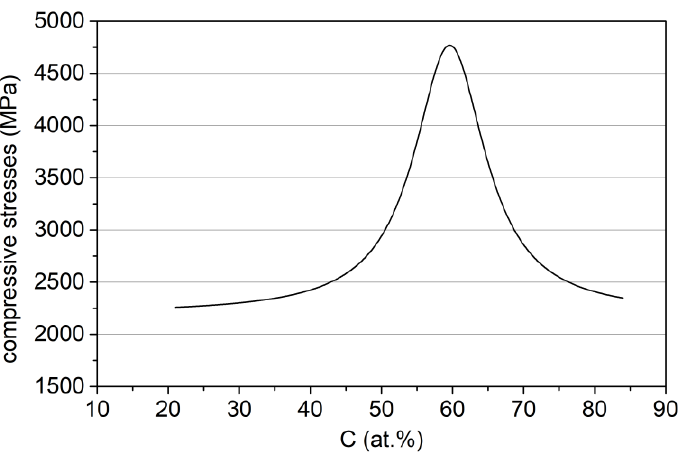
Figure 6. Dependence of the residual stresses, after deposition process, in Zr–C coatings on the concentration of carbon.